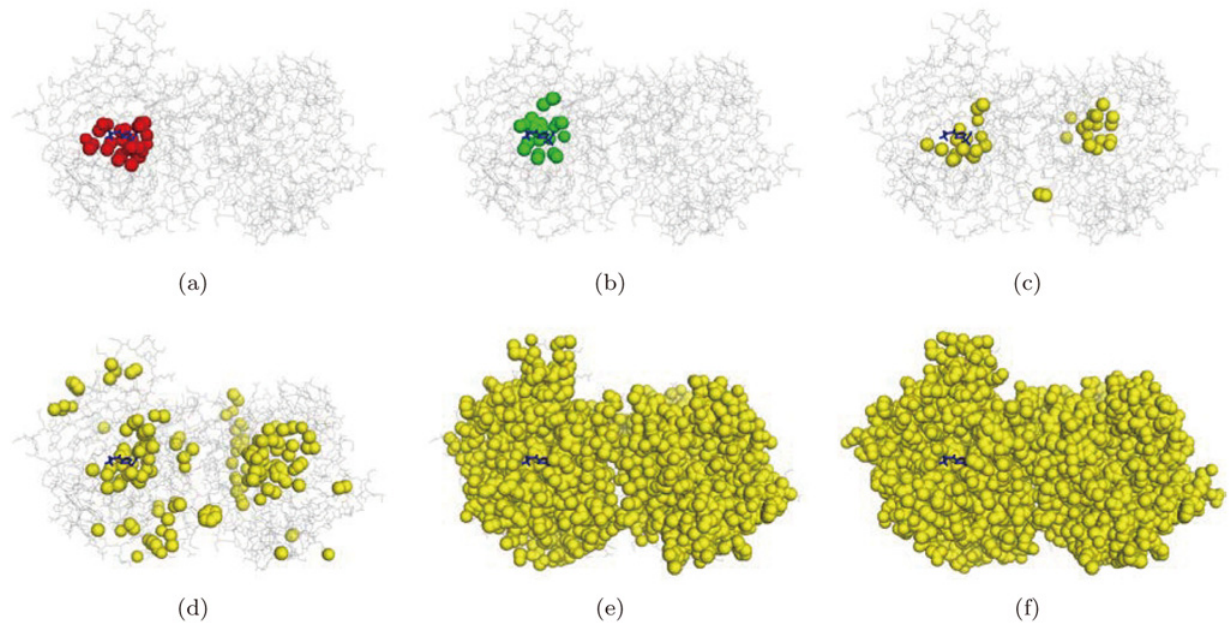
Fig 16. The visualization of pockets (PDB accession code: 1jd0). (a) The optimal pocket, (b) the best matched component produced by the proposed method, (c), (d), (e), and (f) are the atoms recognized by the STP method for the threshold values 80, 60, 40, and 20, respectively.